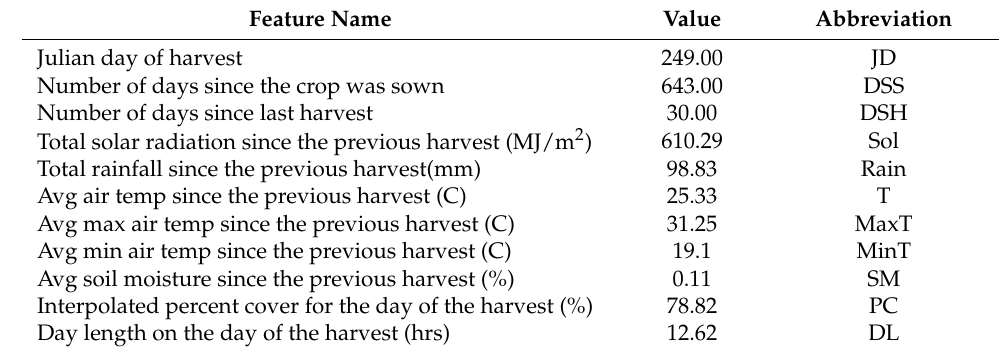
Table 1. A datapoint with the same features as the data used to train our machine learning models. Feature Name Value